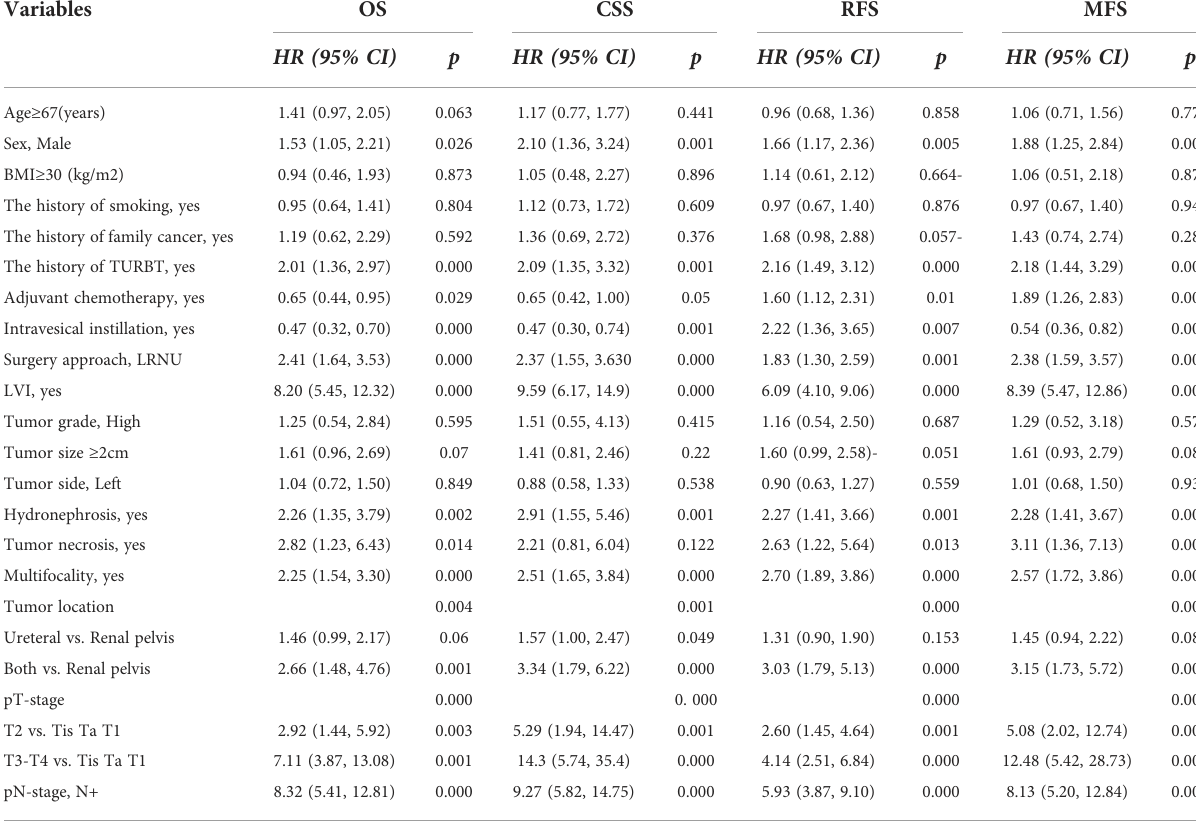
TABLE 2 Univariate Cox proportional hazard regression analysis of the risk factors for UTUC.